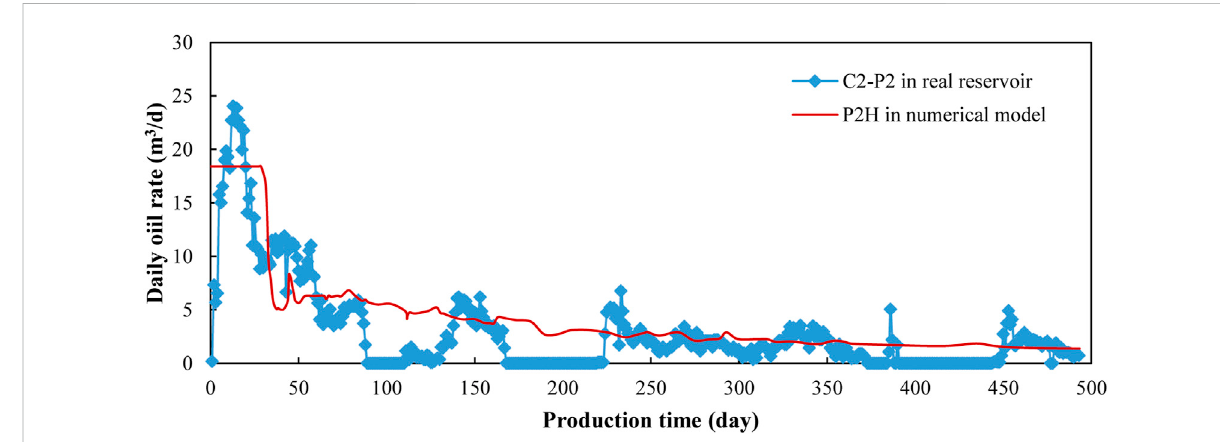
FIGURE 6 Fitting curves of daily oil rates obtained from the real reservoir and numerical model.